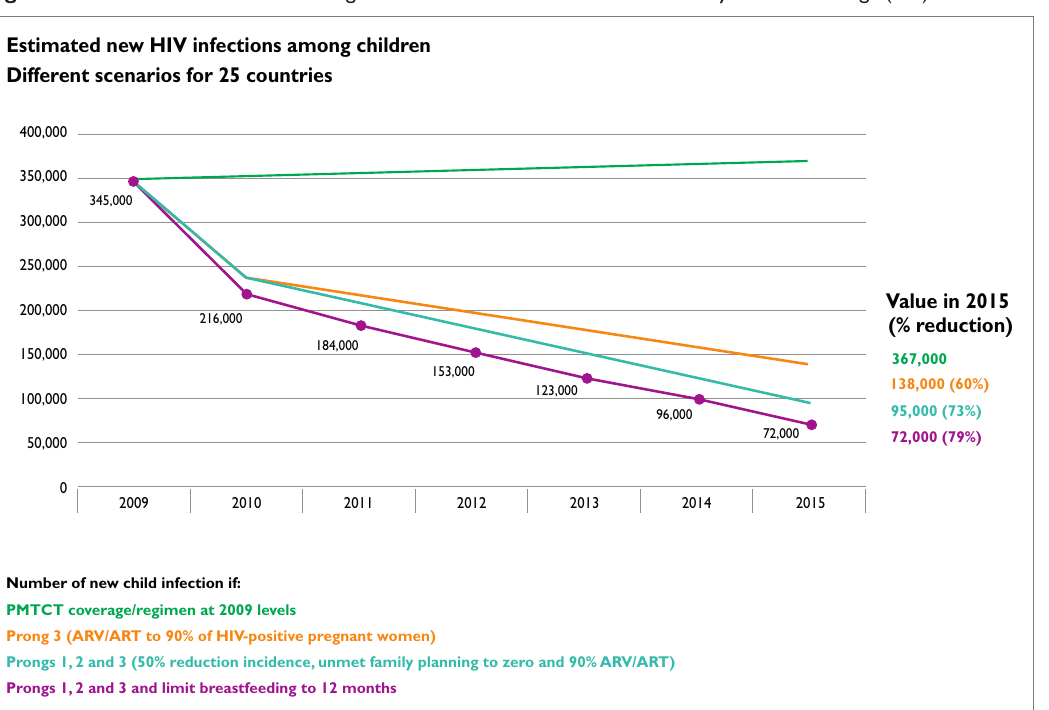
Figure 1. New HIV Infections Among Children in 25 Countries 2009-2015 By PMTCT Prongs (5-6)